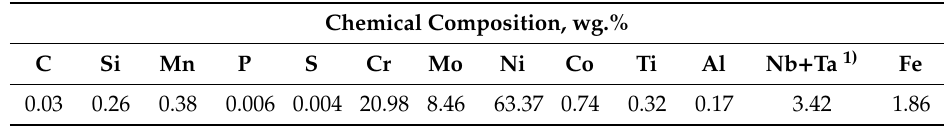
Table 4. Chemical composition of Inconel 625 superalloy, Böhler L625 (EN NiCr22Mo9Nb) powder deposit weld according to spectrometric analysis.